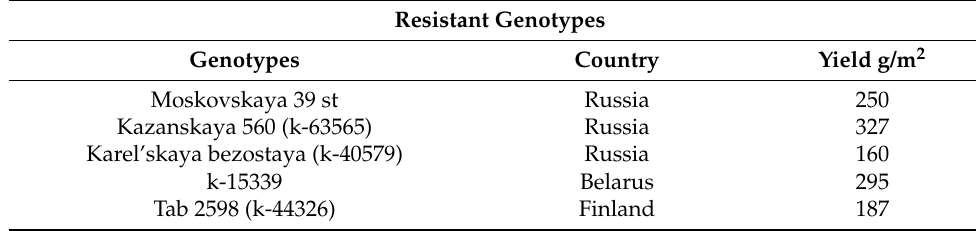
Table 9. Yield of the resistant genotypes (2004–2005).